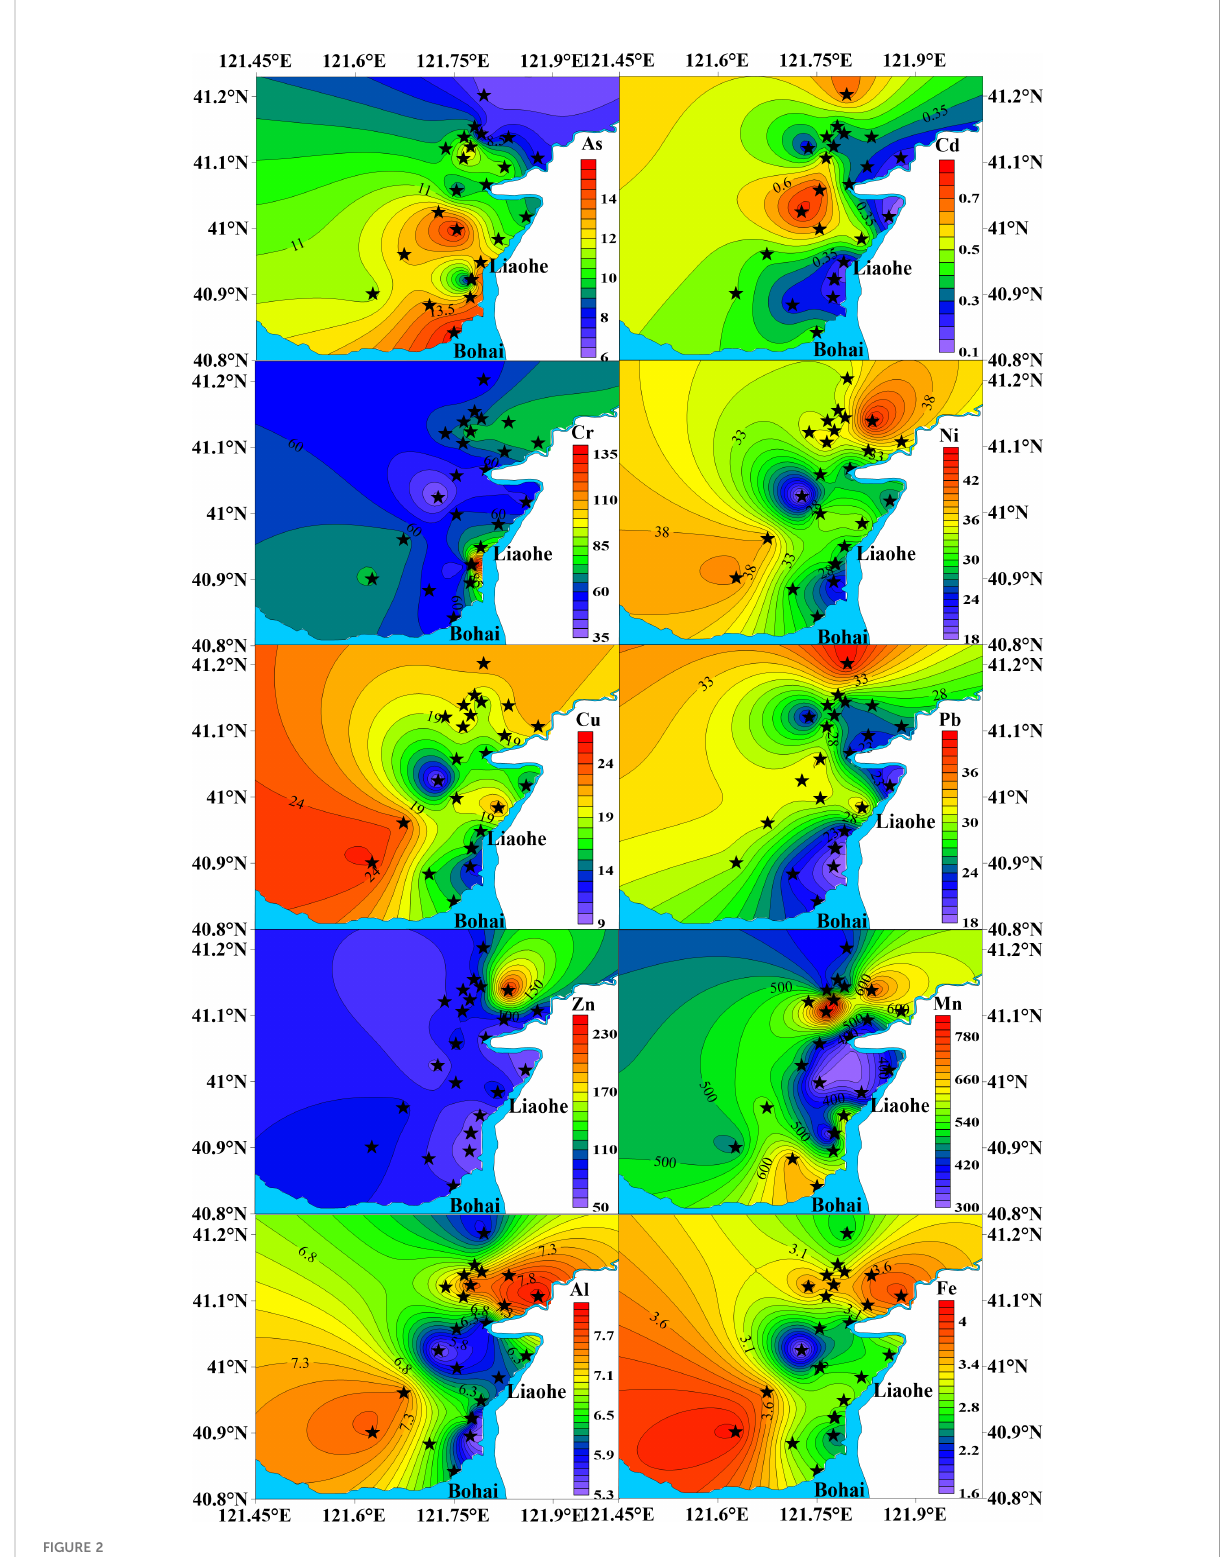
FIGURE 2 Spatial distribution of metals in the surface soil of Liaohe